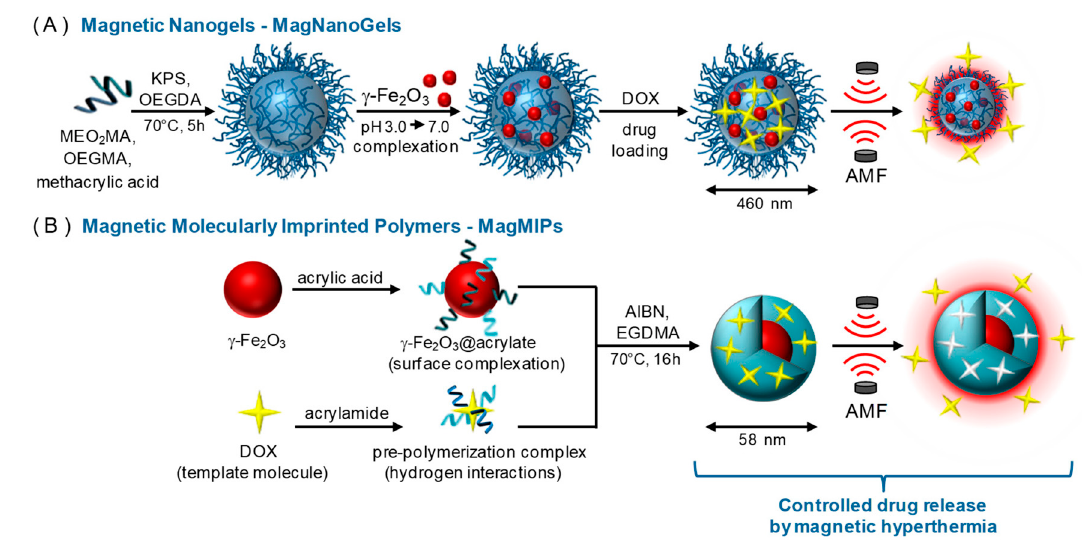
Figure 8. Schematic illustration of the synthesis of ( A ) MagNanoGels by precipitation radical copolymerization and post- assembly of MNPs inside nanogels and ( B ) MagMIPs via a subsequent grafting of an acrylic acid compound in the surface of MNPs and the growth of the polymer in the presence of DOX for imprinting polymerization. Loading and release of DOX under an AMF. Reproduced with permission from Cazares-Cortes et al. [71].